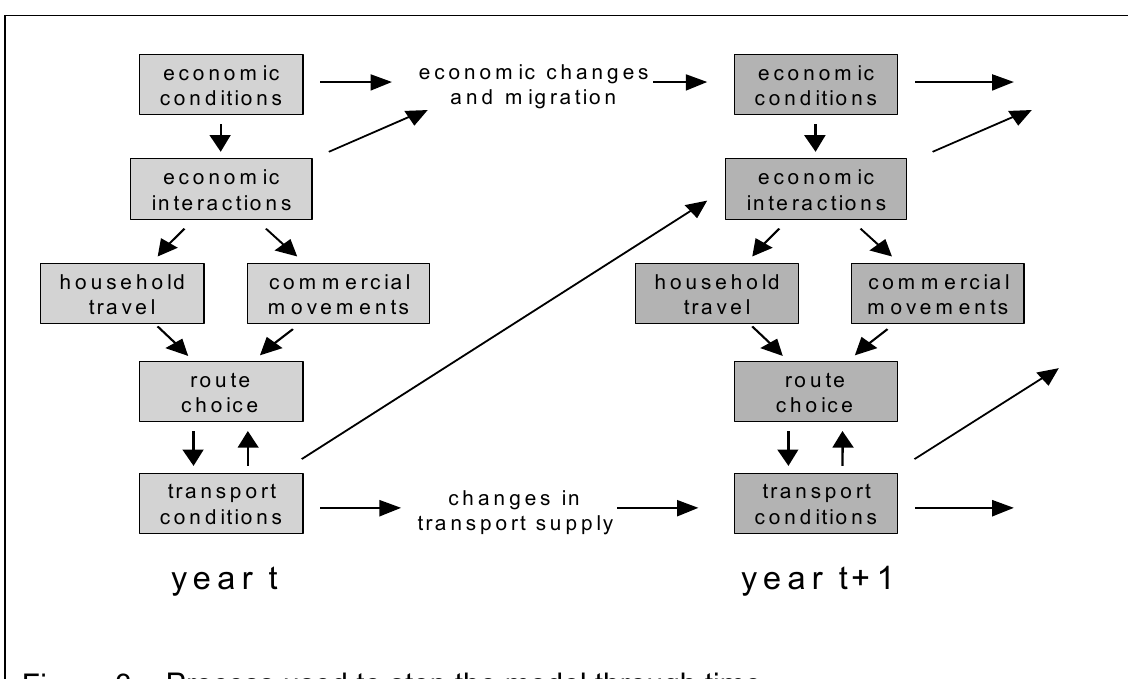
Figure 3: Process used to step the model through